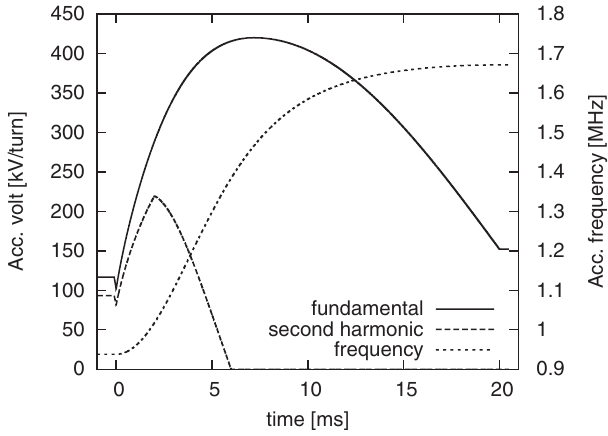
FIG. 2. Typical rf frequency and voltage programs of the RCS used in the longitudinal tracking simulation.